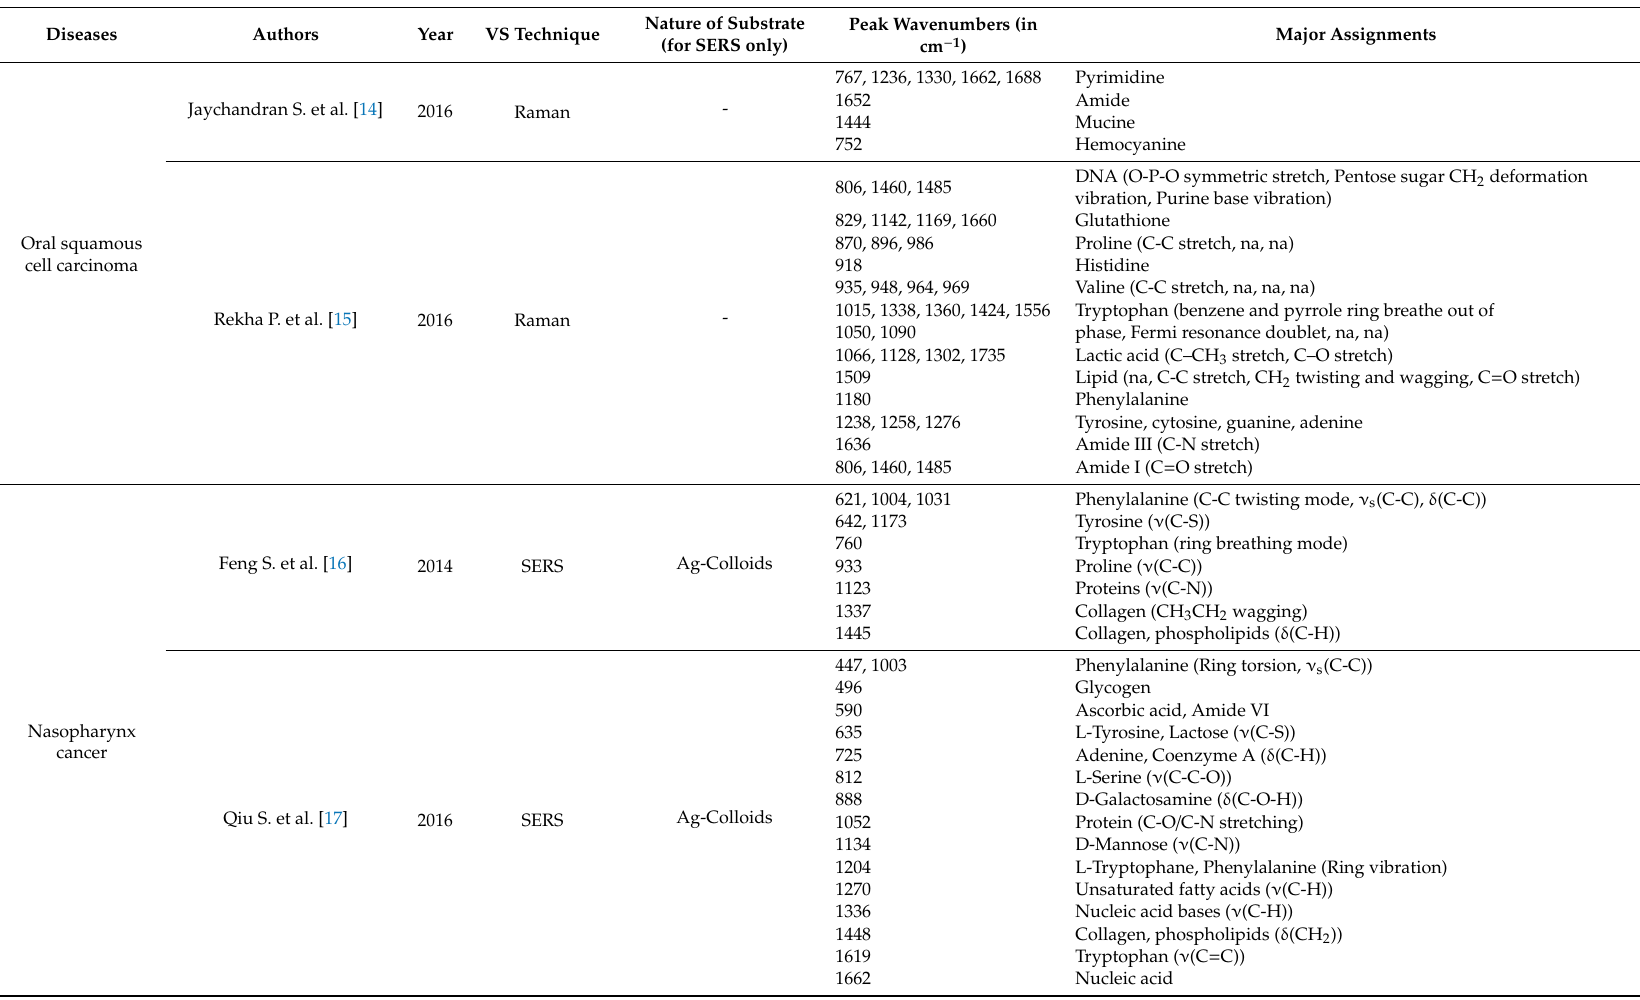
Table 2. Molecular biosignatures and tentative assignments identified from saliva using FTIR, Raman, and SERS to diagnose di ff erent diseases.